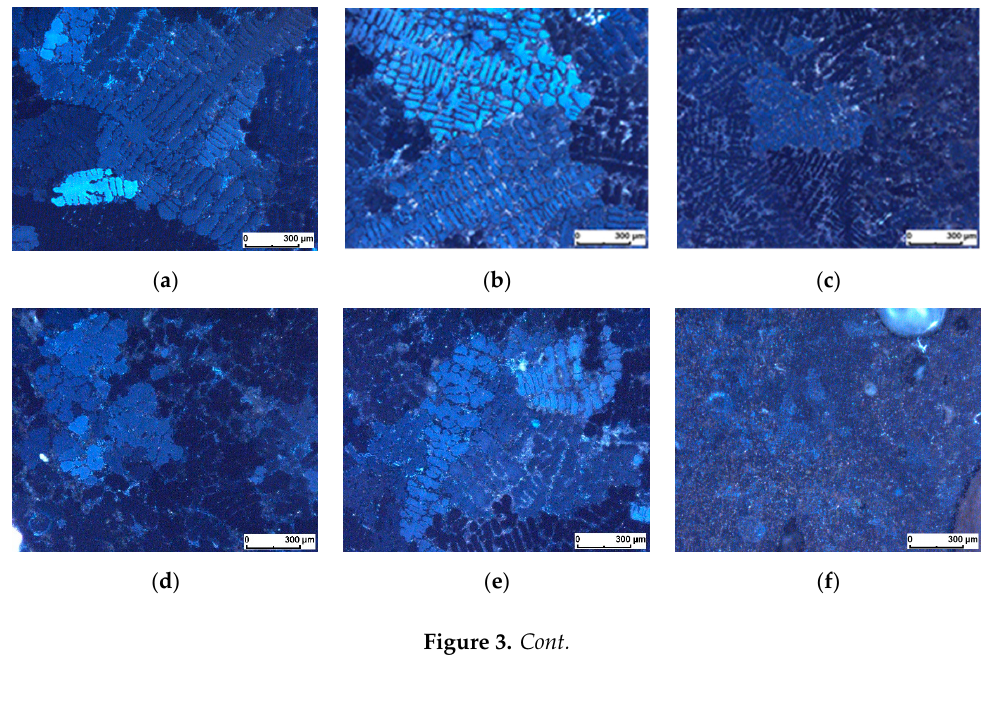
Figure 2. Average grain size of powder compacts, ( a ) as a function of Sr, B and TiB 2 additive content when quenched in water, ( b ) depending on cooling rate for reference material without additives and samples containing medium levels of Sr, B and TiB 2 addition as given in the diagram.